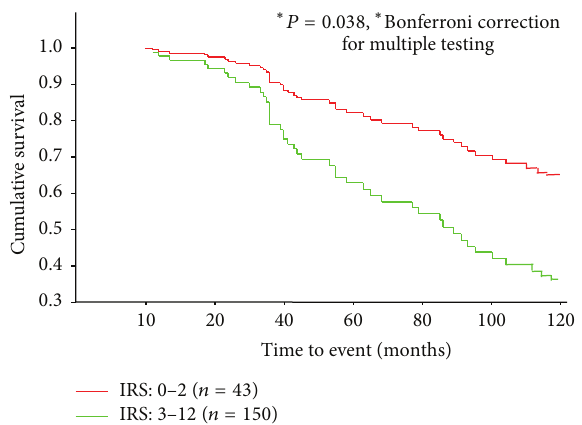
Figure 2: Relationship between PGIS expression and overall sur- vivalof193patients.TheKaplan-Meiersurvivalcurvesshownarefor subgroups with either low (IRS2) or high (IRS ≥ 3) PGIS expression among all patients under